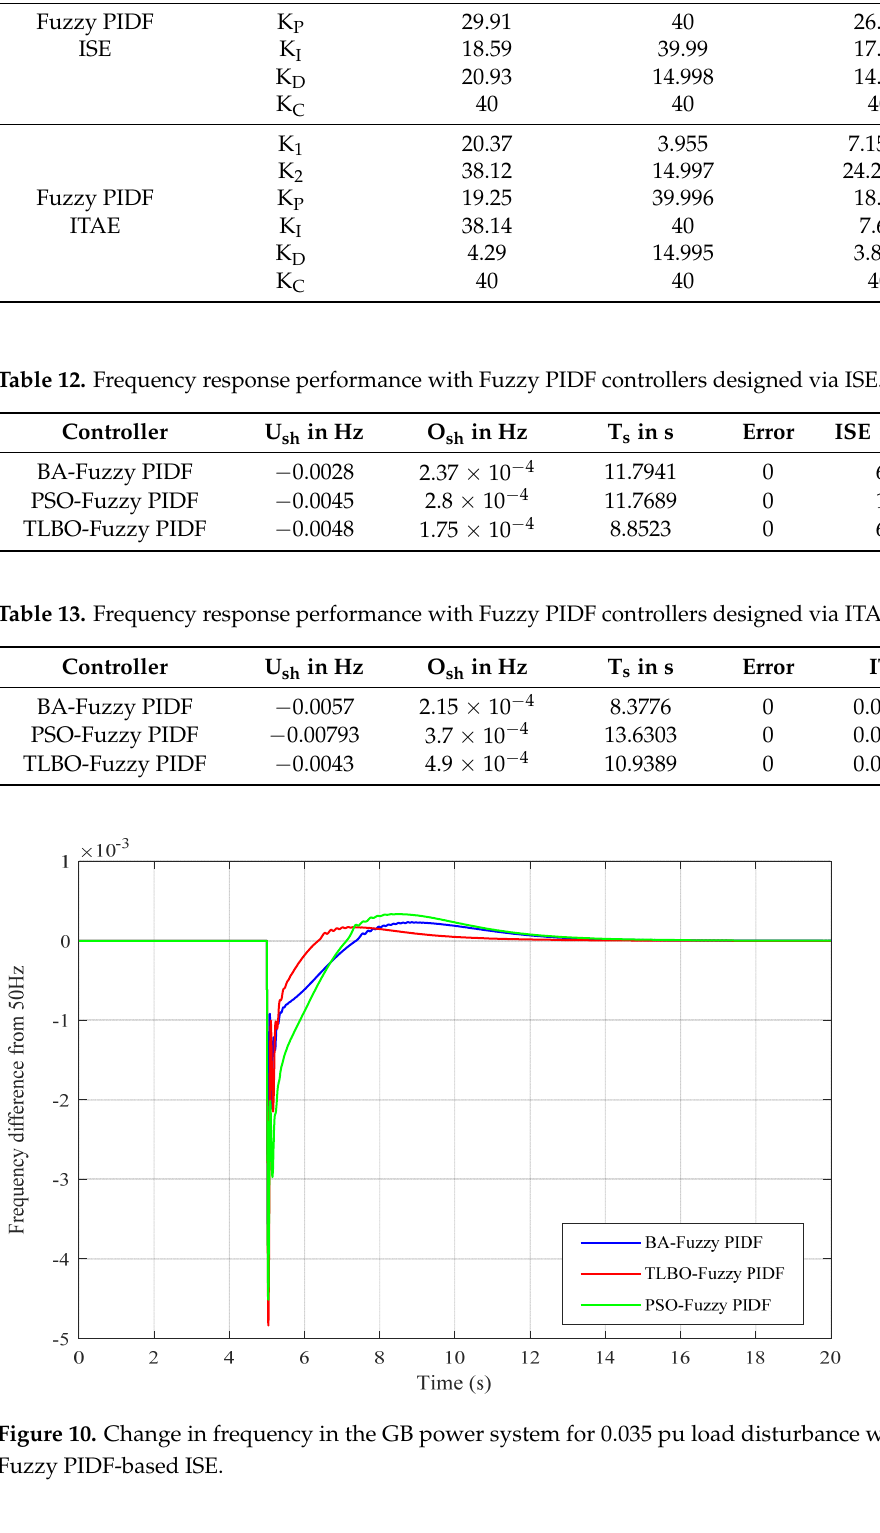
Figure 11. Change in frequency in the GB power system for 0.035 pu load disturbance with tuned Fuzzy PIDF-based ITAE.